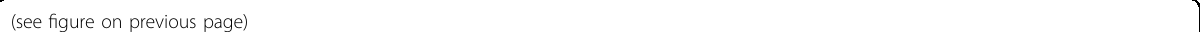
Fig. 6 Renal TEC-speci fi c GSK3 β gene deletion or lithium improves kidney fi brosis in folic FA-elicited progressive CKD. A Schematic diagram of the strategy for generation of mice with renal tubular epithelial cell-speci fi c GSK3 β gene knockout (KO). B Representative photos showing PCR analysis of the genomic DNA extracted from the clipped tail tissues. Genotypes of representative litters are indicated; fl , GSK3 β fl oxed; WT, wild type. Mice with the genotype GSK3 β fl / fl , Cre were used as KO group. Control littermates served as control (Con). C The schematic diagram depicts the experimental design. Mice were injured with an injection of FA (250 mg/kg) and 7 days later were treated with or without LiCl (40 mg/kg). Mice were followed up and euthanized on day 14 after FA injection, blood and kidney specimens were collected and processed for further examinations. D Quanti fi cation of blood urea nitrogen (BUN). * , ** , *** P < 0.05 ( n = 6, ANOVA followed by Tukey ’ s test). E Kidney specimens were homogenized for immunoblot analysis for FN, GSK3 β , and GAPDH. Representative immunoblots were shown. F Densitometric analyses of the expression of FN and GSK3 β , as normalized to the expression of GAPDH and expressed as fold changes relative to the control group based on immunoblot analysis. * , ** , *** P < 0.05 ( n = 6, ANOVA followed by Tukey ’ s test). G Representative micrographs of immuno fl uorescence staining for FN (red) with nuclear counterstaining with DAPI (blue), or immunohistochemistry staining for collagen I. Scale bar = 100 μ